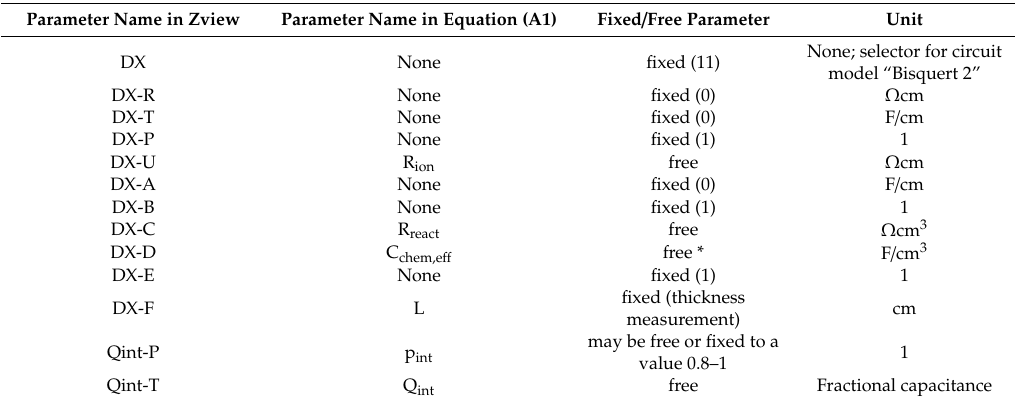
Table A1. Relation of Zview fitting parameters to the impedance function in Equation (S1).